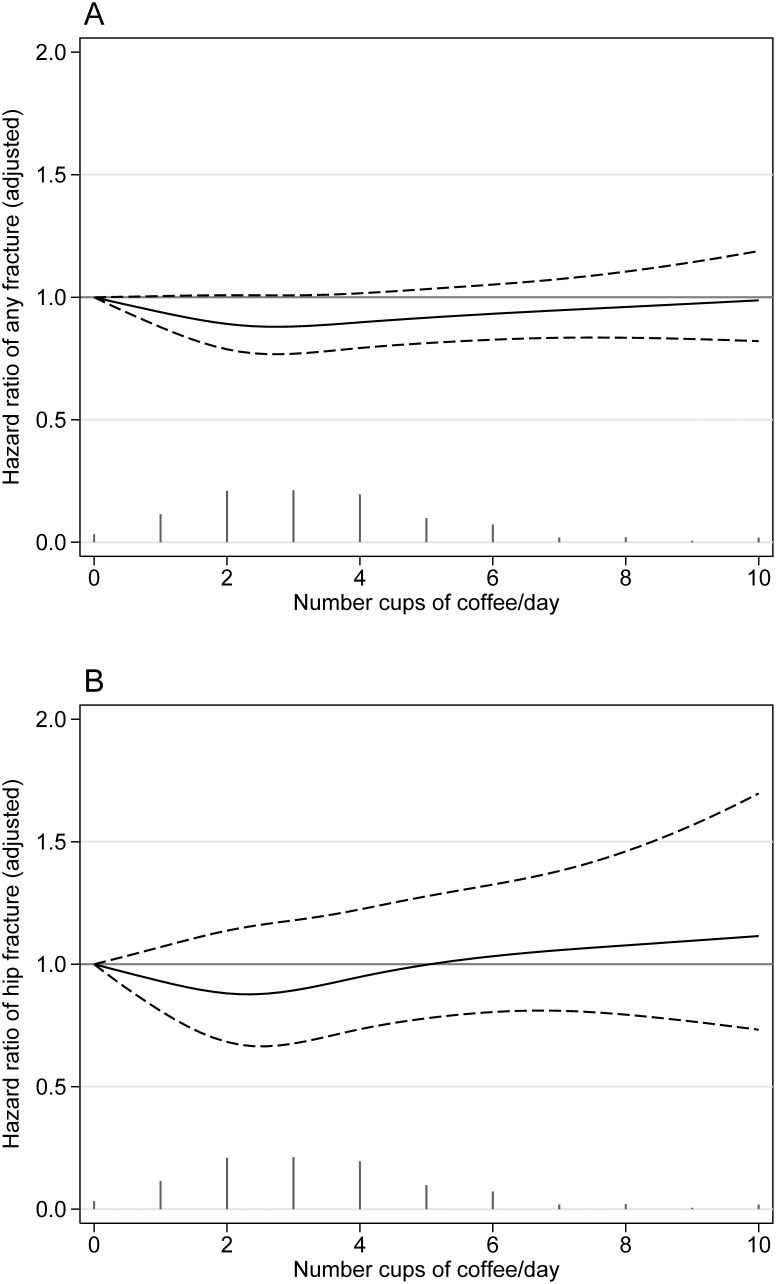
Association between coffee consumption and fracture risk.Multivariate-adjusted hazard ratios (HR) with 95% confidence intervals (CI) (dashed lines) of any fracture (Panel A) and hip fracture (Panel B) by coffee consumption. The vertical bars represent the distribution of coffee intake. The smoothed curves were fitted with a restricted cubic spline model with a consumption of <1 cup of coffee as the reference. Adjustments were made for intake of energy, protein, calcium, retinol, vitamin D, phosphorus, potassium and alcohol, body mass index, height, physical activity (MET-24 h score) (all continuous), intake of any vitamins, cortisone use, educational level (≤9, 12, >12 years, other), smoking status (never, former, current), previous fractures (yes or no) and Charlson’s comorbidity index (continuous).